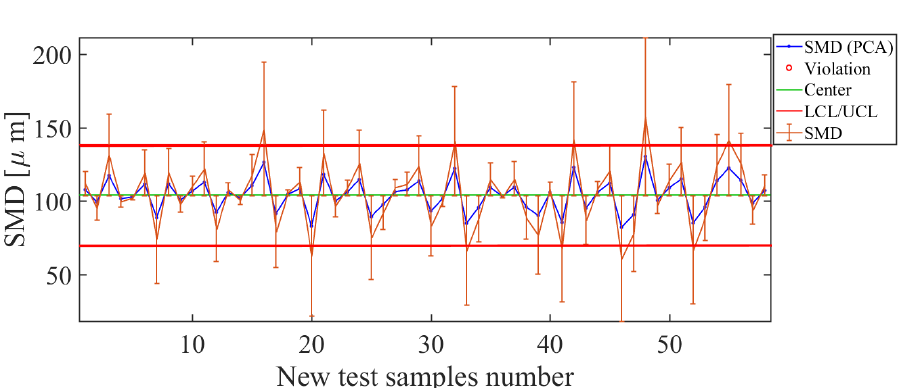
Figure 12. Soft-sensor response (control chart and error bars) for the Sauter mean diameter (SMD) de- scriptor. For values of SMD > 140 µ m and SMD < 60 µ m, high estimation error levels are